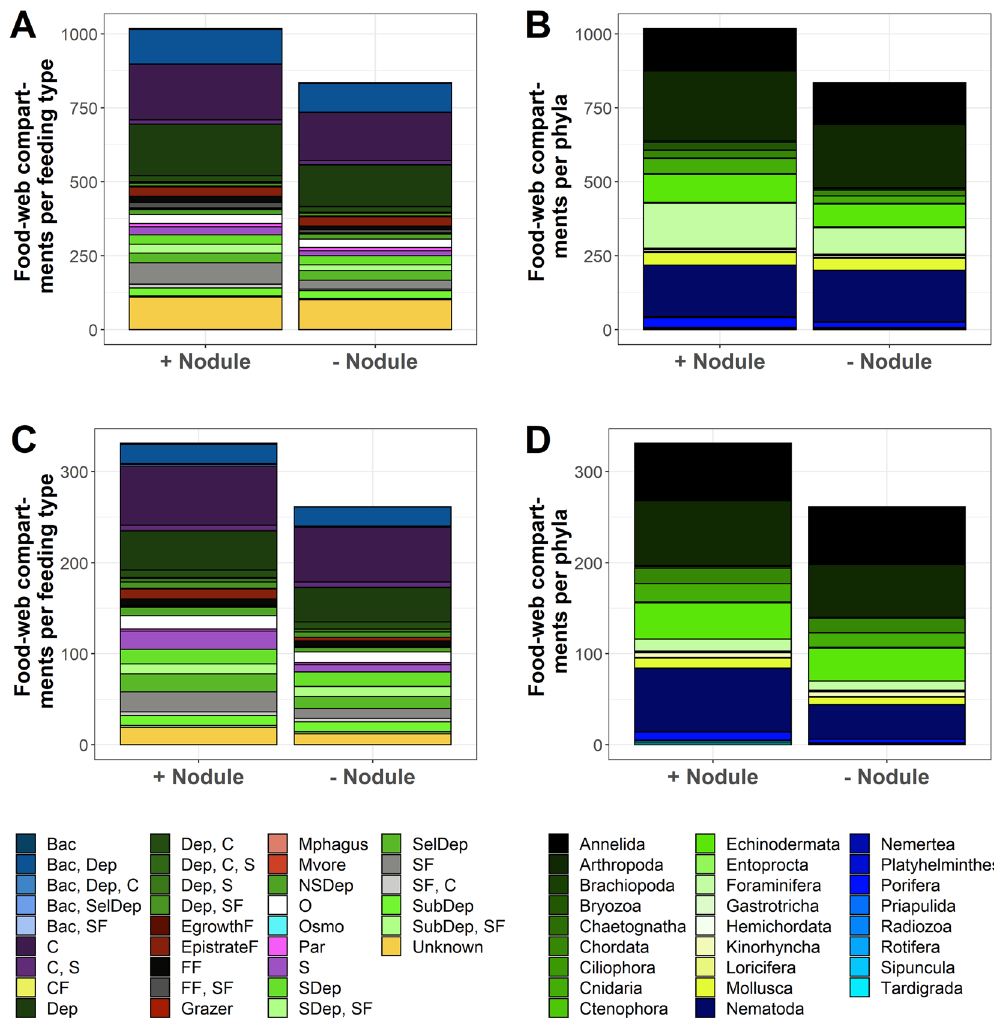
Figure 1. Number of feeding types and phyla present in the Clarion-Clipperton Fracture Zone (CCZ) and the Peru Basin. ( A ) All compartments that are part of trophic and non-trophic interaction webs of the CCZ are split into feeding types and shown in the presence (+ nodule) and after removal (− nodule) of polymetallic nodules. ( B ) All compartments from the CCZ interaction webs are divided into phyla and presented in the presence (+ nodule) and after removal (− nodule) of nodules. ( C ) All compartments of the Peru Basin interaction web shown as feeding types in the presence (+ nodule) and after removal (− nodule) of nodules. ( D ) All phyla that occur in the Peru Basin in the presence (+ nodule) and after removal (− nodule) of nodules. Bac bacterivore, C carnivore, CF ciliate feeder, Dep deposit feeder, EgrowthF epigrowth feeder, EpistrateF epistrate feeder, FF filter feeder, Mphagus microphagous, Mvore microvore, NSDep non-selective deposit feeder, O omnivore, Osmo osmotroph, Par parasitic, S scavenger, SDep surface deposit feeder, SelDep selective deposit feeder, SF suspension feeder, SubDep subsurface deposit feeder, Unknown unknown feeding